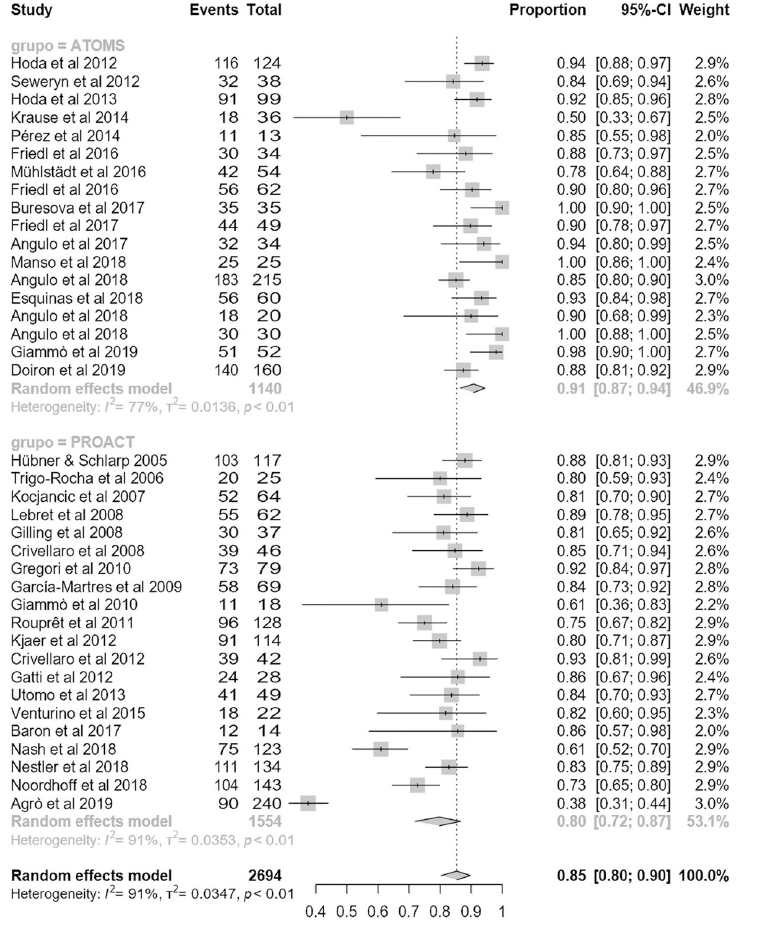
Fig 3. Forest plot of studies analyzed for improve rate.